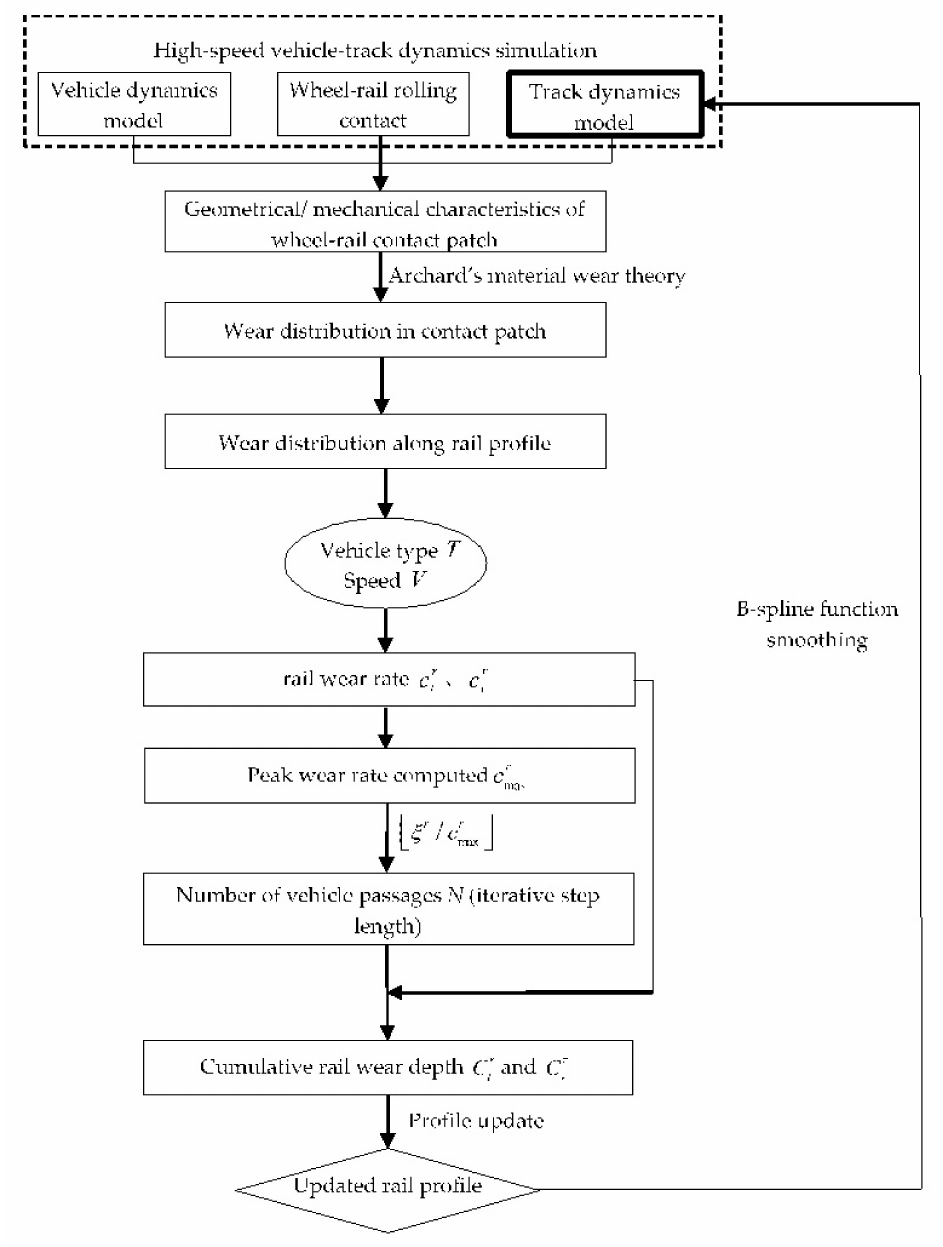
Figure 13. Iterative computation process for numerical prediction of rail wear